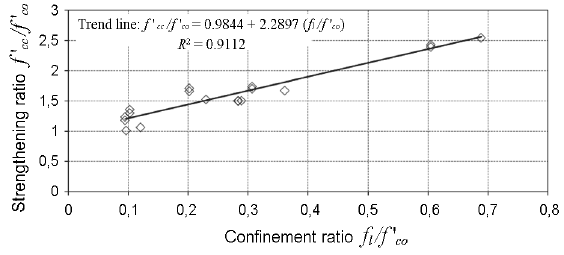
Fig. 13. Strengthening ratio vs. confinement ratio